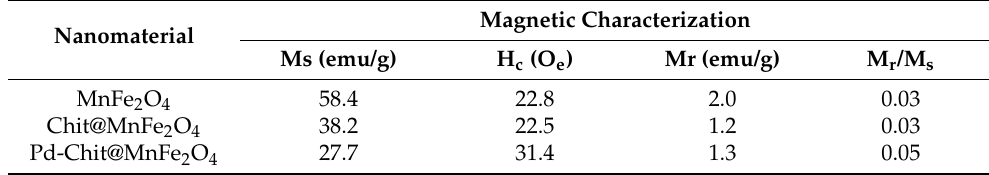
Table 2. Magnetic properties of MnFe 2 O 4 , Chit@MnFe 2 O 4 , and Pd-Chit@MnFe 2 O 4 .